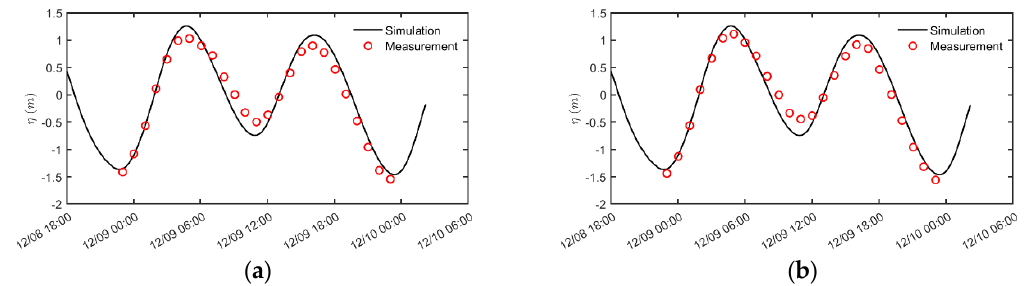
Figure 9. Comparison between the numerical results and the measured surface elevation at Gauges P1 and P2 for the Bohai Bay case. ( a ) P1; ( b ) P2.